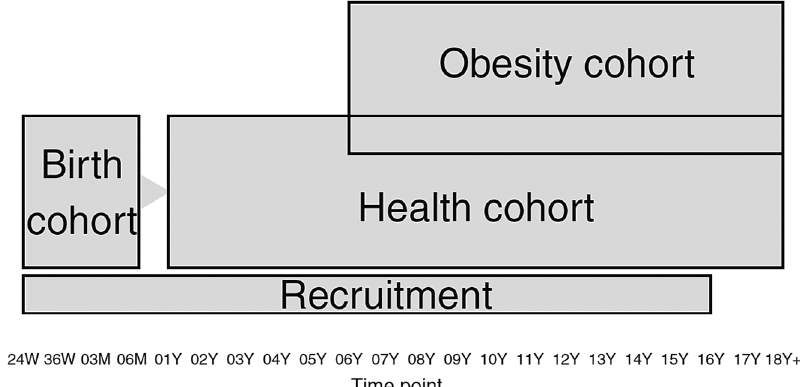
Figure 1: Study cohorts in the LIFE Child study and their interrelations. W,weeks ofgestation;M,age of childrenin month; Y, age of children in years. With permission from ref.